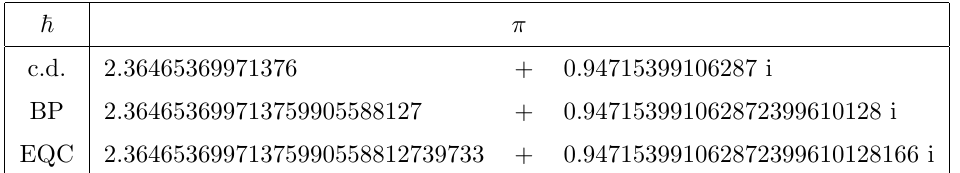
Table 3 . First resonance for local F 0 with log (cid:24) F